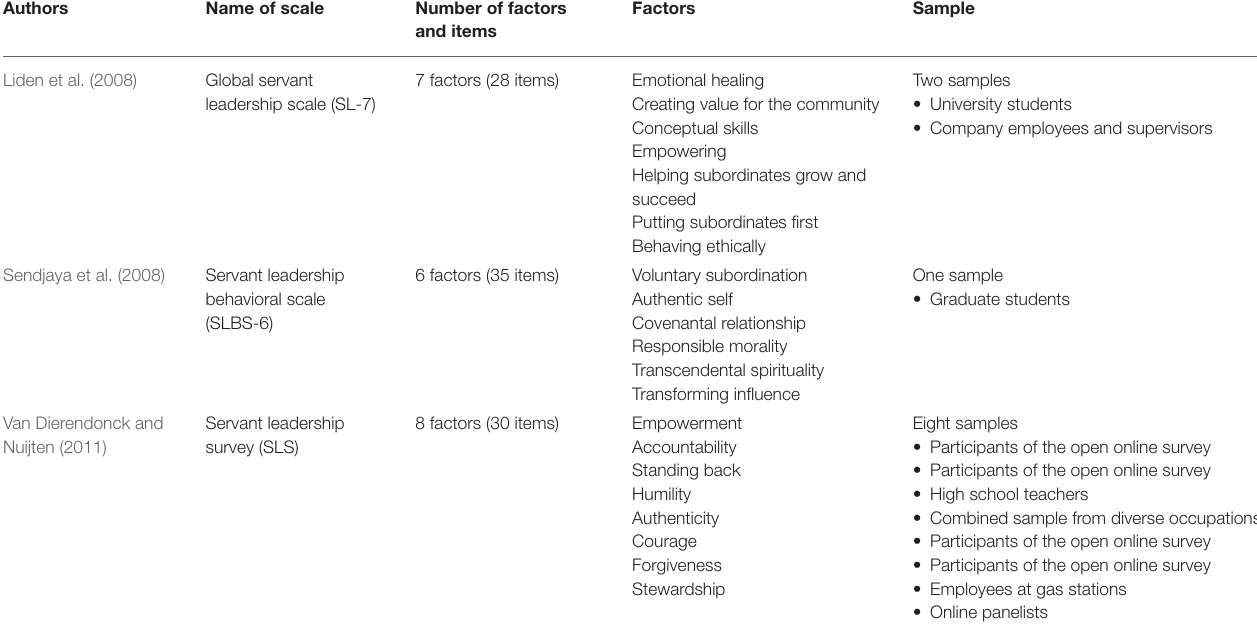
TABLE 1 | Three servant leadership scales recommended by Eva et al. (2019).